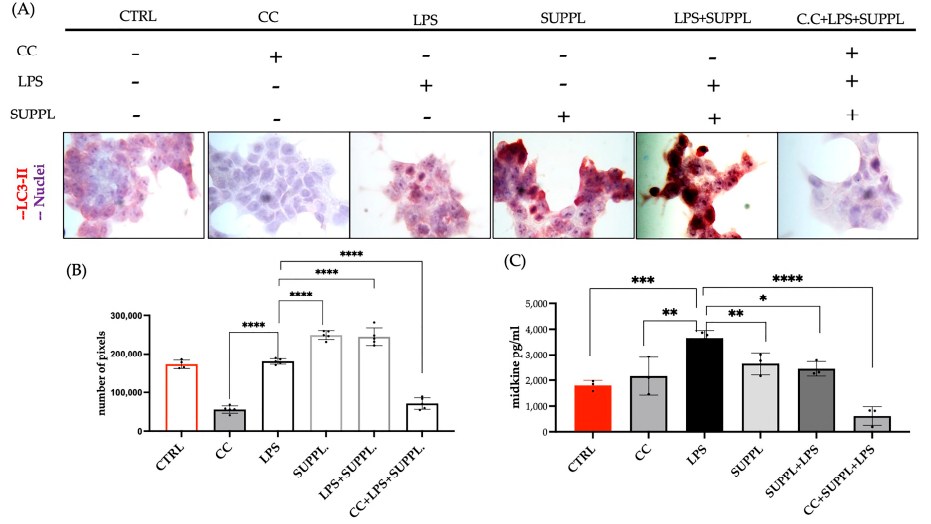
Figure 8. ( A ) Exposure of NCM460 cells to the supplement (SUPPL, 1.2 µ M spermidine (SPD)) + 92 µ M eugenol (EUG), lipopolysaccharide (LPS, 1 ng/mL) and Compound C (CC, 5 µ M) either alone or in combination compared to the untreated control (CTRL). ( A ) Red chromogen-stained LC3-II expression at × 40 mag with ( B ) LC3-II expression quantification and ( C ) comparison to midkine levels. Compound C was administered 30 min prior to the addition of the SUPPL and SUPPL pretreatments were for 1 h prior to LPS exposure for 4 h. Significant differences were represented as follows: * 0.01 < p < 0.05, ** 0.001 < p < 0.01, *** 0.0001 < p < 0.001, **** p < 0.0001. The black dots indicate the positioning of the individual replicates within the bar for each sample.